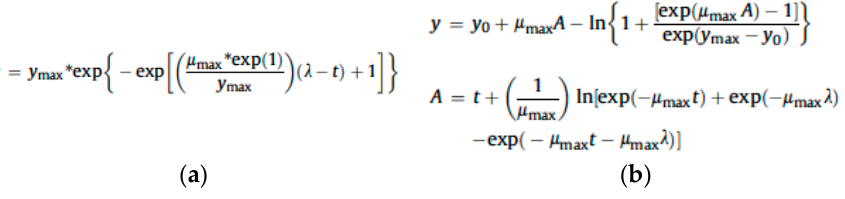
Figure 2. ( a ) Gompertz and ( b ) Baranyi growth models. Notes: y = size; y max = maximum size; Figure 2. ( a )Gompertz and ( b )Baranyi growth models. Notes: y = size; y max = maximum size; y 0 = initial y 0 = initial size; λ = lag time; µ max = maximum growth rate; t = size; λ = lag time; μ max = maximum growth rate; t = time.